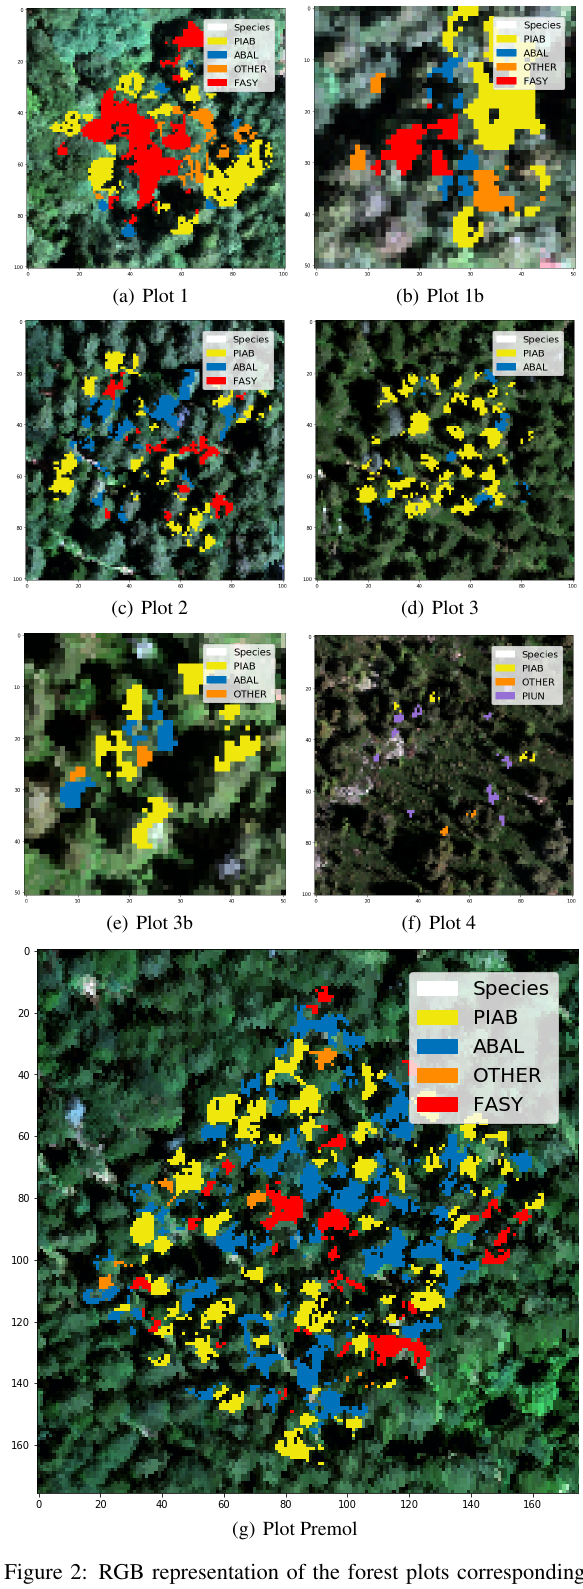
Figure 2: RGB representation of the forest plots corresponding to the Chamrousse site with the following color labels: Abies alba (ABAL), Fagus sylvatica (FASY), Picea abies (PIAB), Pinus uncinata (PIUN) and “other”